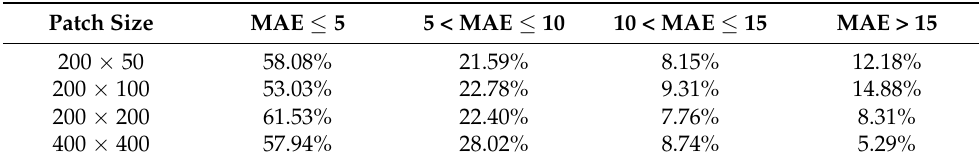
Figure 5. The scatterplots in patch level: ( a ) the patch size is 200 × 50; ( b ) 200 × 100; ( c ) 200 × 200; ( d ) 400 × 400. Table 2. The percentage of patches in different MAE intervals.